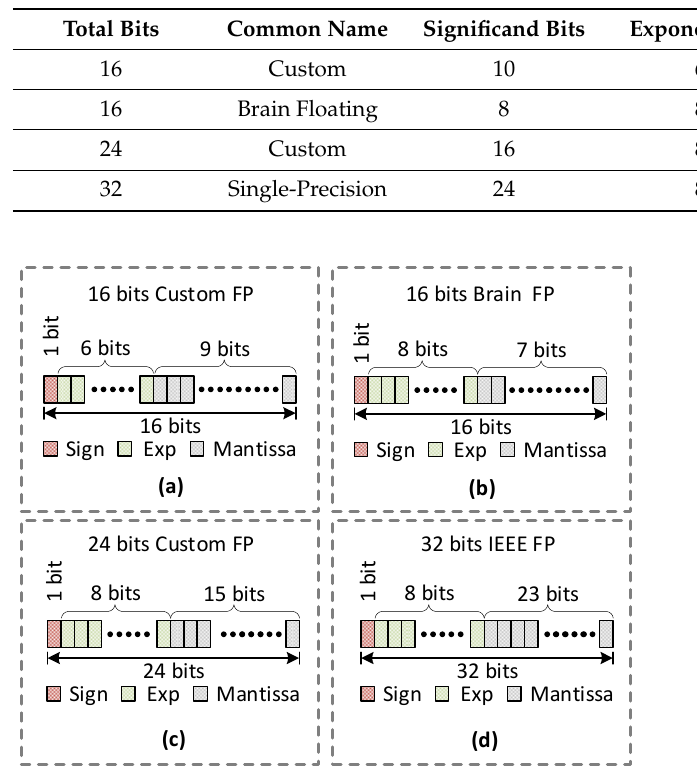
Figure 4. The representation of floating-points ( a ) 16-bit custom floating points; ( b ) 16-bit brain floating point; ( c ) 24-bit custom floating point; ( d ) 32-bit single precision.